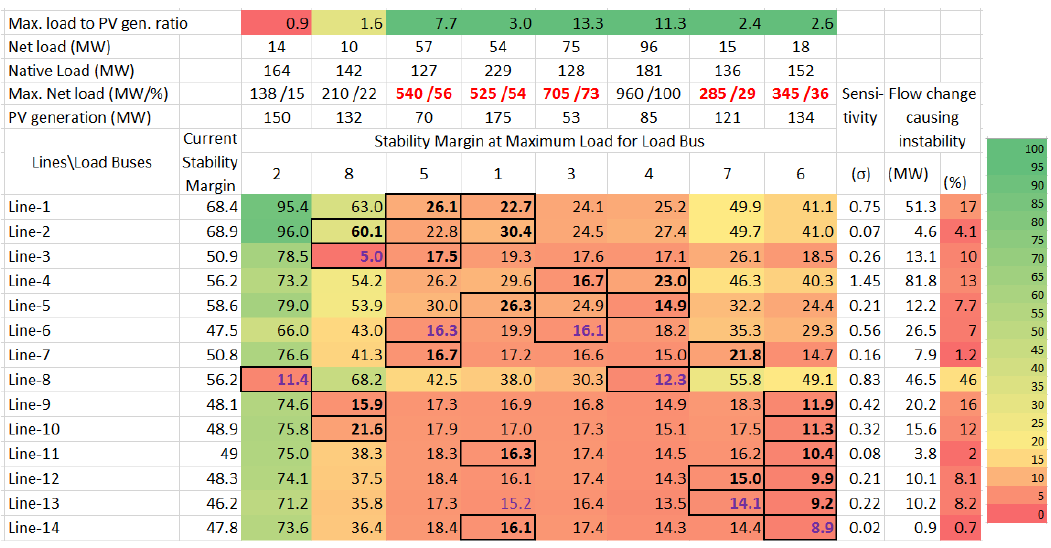
Figure 8. Heat map with generator in vicinity of Load Bus-3 out of service, where buses that had their Percent Loading changed are noted with red text.